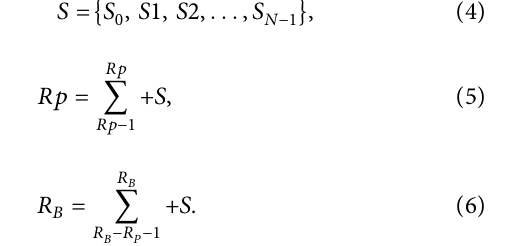
described in Table